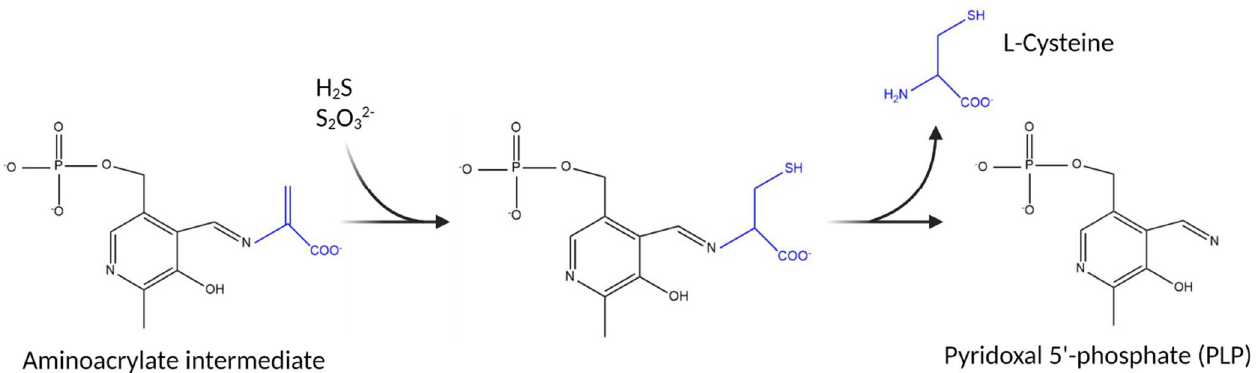
Figure 2. Second half-reaction of PLP-dependent cysteine synthase. Nucleophilic attack by the sulfur donor, shown here as either hydrogen sulfide or thiosulfate, upon the α -aminoacrylate group at the β -carbon position leads to reprotonation of the α -carbon and formation of a cysteine adduct as an external Schiff base. The internal aldimine is subsequently regenerated, releasing free cysteine and completing the overall reaction.